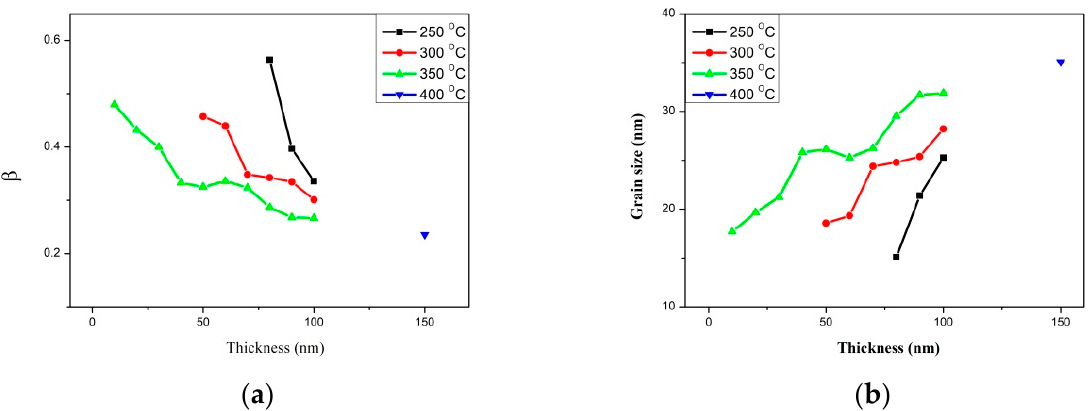
Figure 2. ( a ) Full-width at half maximum (FWHM) of CoFeWB thin films. ( b ) Grain size of CoFeWB thin films.